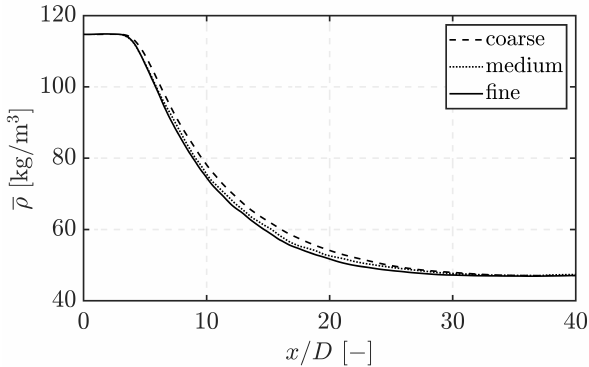
Figure 2. Grid convergence study for the mean density extracted along the center line for case SoS _1. Coarse, medium, fine refer to grid resolutions 30, 45, and 60 cells over the nozzle